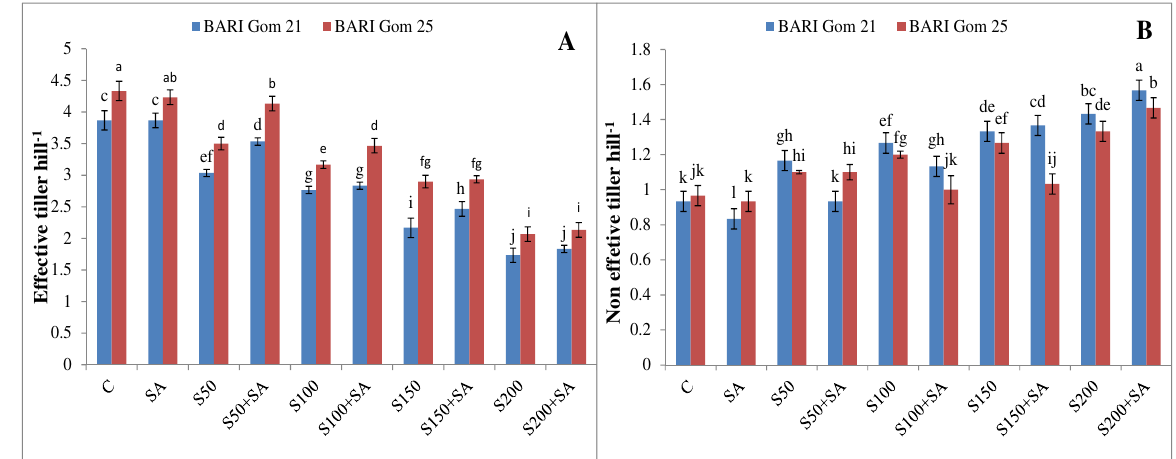
Fig. 6. ( A ) Effective tiller hill -1 and ( B ) Non effective tiller hill -1 in salt sensitive and salt tolerant wheat plants induced by exogenous salicylic acid under salt stress. S50, S100, S150 and S200 indicate 50 mM, 100 mM, 150 mM and 200 mM NaCl, respectively. SA indicates 1 mM salicylic acid spray, respectively. Mean (±SD) was calculated from three replicates for each treatment. Values in a column with different letters are significantly different at p ≤ 0.05 applying LSD test